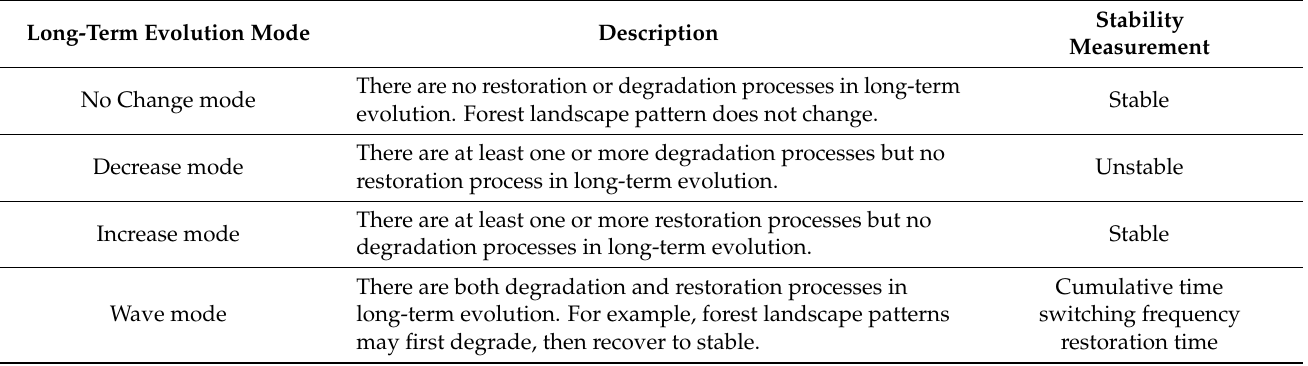
Table 3. Definition of long-term evolution based on degradation, restoration, and stable